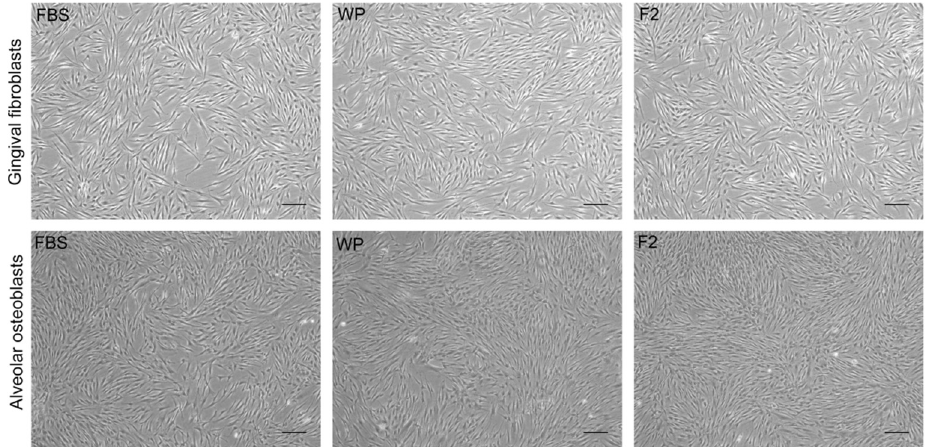
Figure 1. Representative phase contrast images of in vitro cell expansion after the use of PRGF (WP, F2) or FBS as culture medium supplement. Scale bar: 200 µm. F2) or FBS as culture medium supplement. Scale bar: 200 µ m.